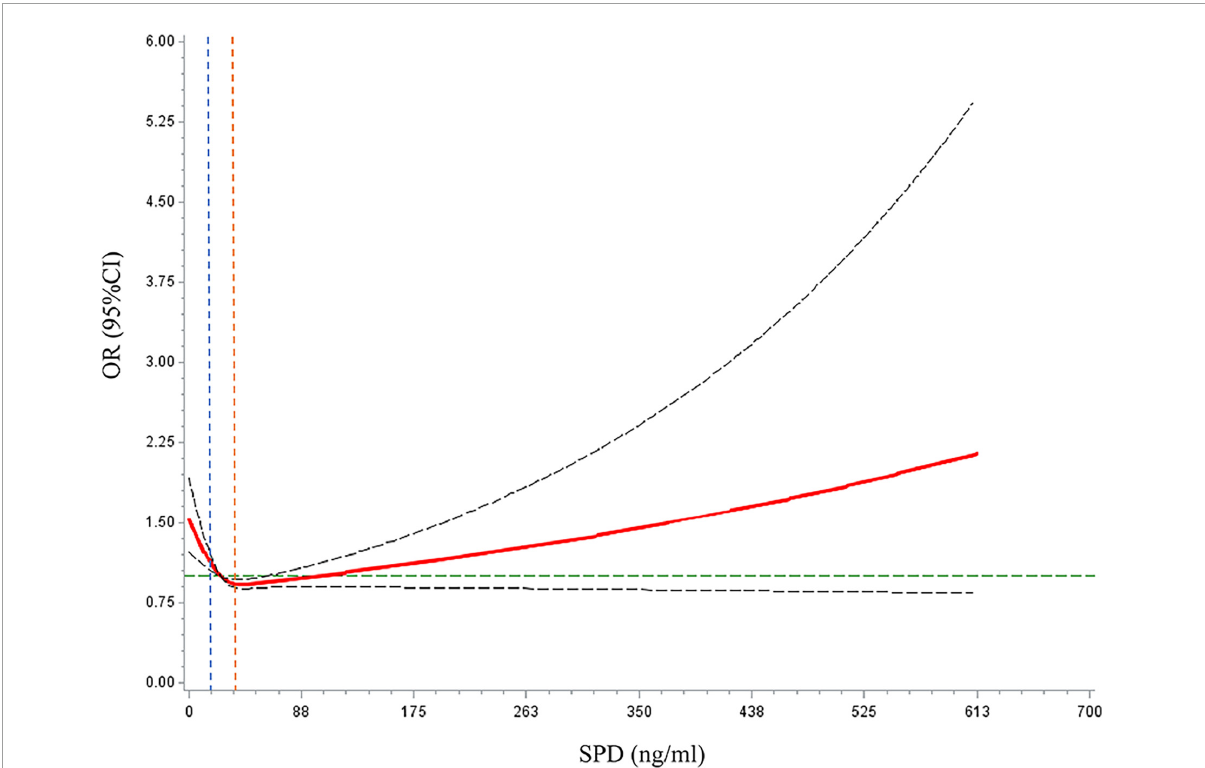
FIGURE3 Dose–response relationships between spermidine (SPD) and mild cognitive impairment (MCI) prevalence. The solid red line represents the dose–response curve. The dashed black lines represented the 95% confidence interval. The dashed green line represents the reference line for OR = 1. The blue dashed line represents the reference line for the first tertile of SPD (SPD = 16.69 ng/ml). The orange dashed line represents the reference line for the third tertile of SPD (SPD = 37.29 ng/ml).